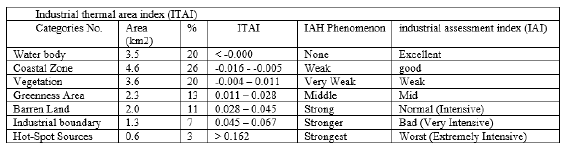
Table 9. The threshold of the industrial assessment index (ITAI) for Pasir Gudang